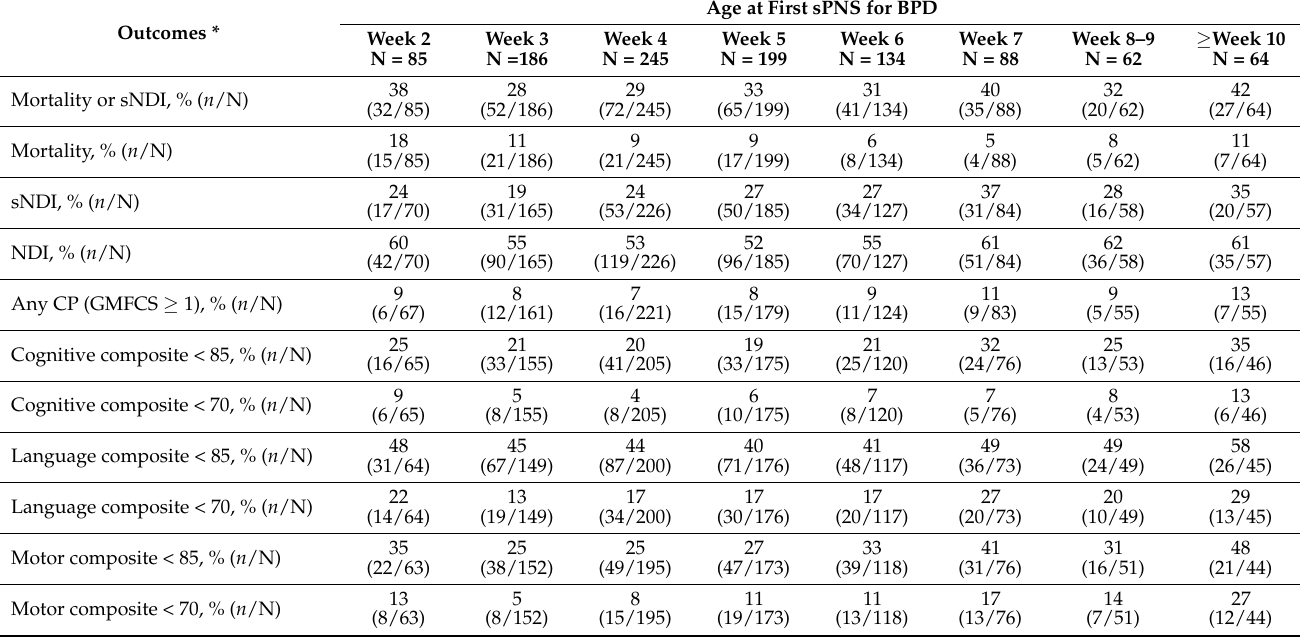
Table 4. Neurodevelopmental outcomes in the infants exposed to systemic postnatal steroids.